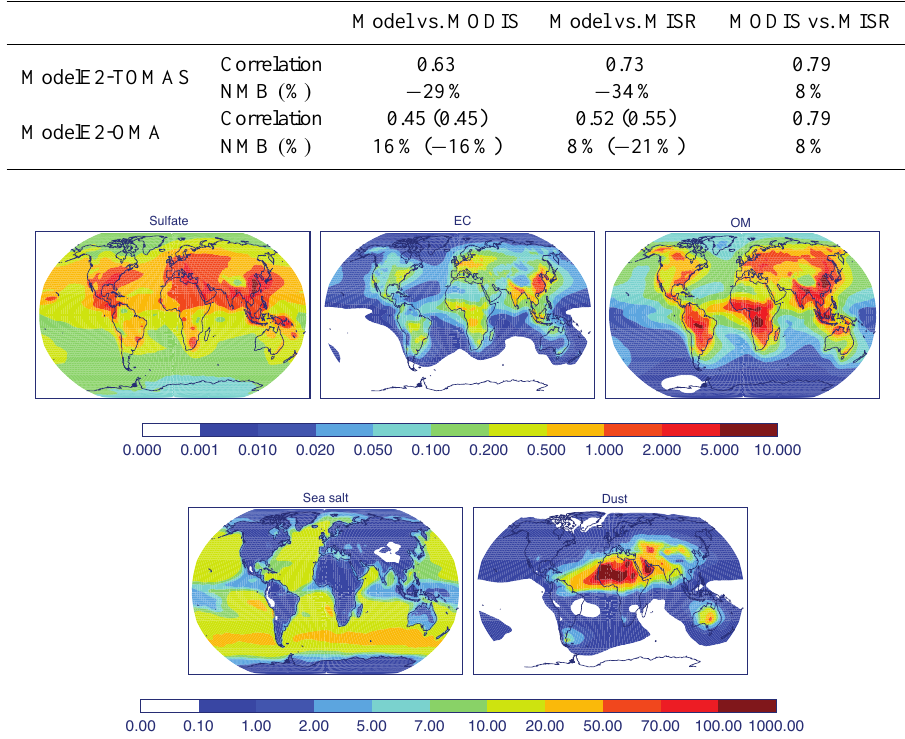
Figure 6. Annual-mean concentrations of (a) sulfate, (b) EC, (c) OM, (d) sea salt, and (e) dust in the lowermost layer in the ModelE2- TOMAS BASE run. Units are µgm − 3